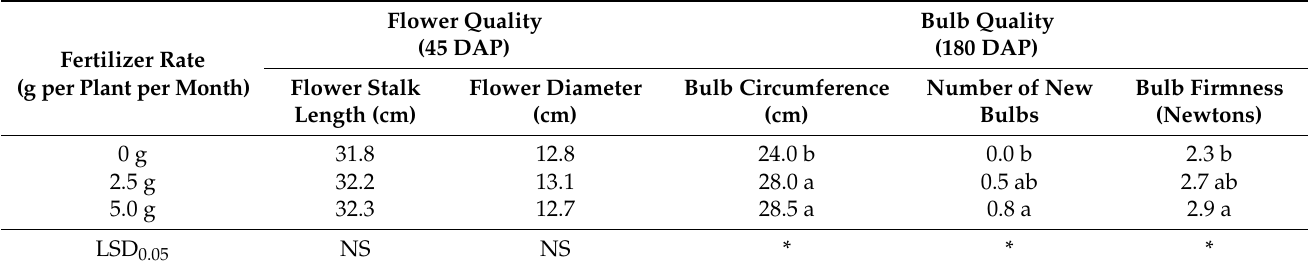
Table 2. Effects of fertilization rates on flower and bulb qualities of Hippeastrum ‘Red Lion’ at the flowering stage (45 DAP) and bulb harvesting stage (180 DAP).